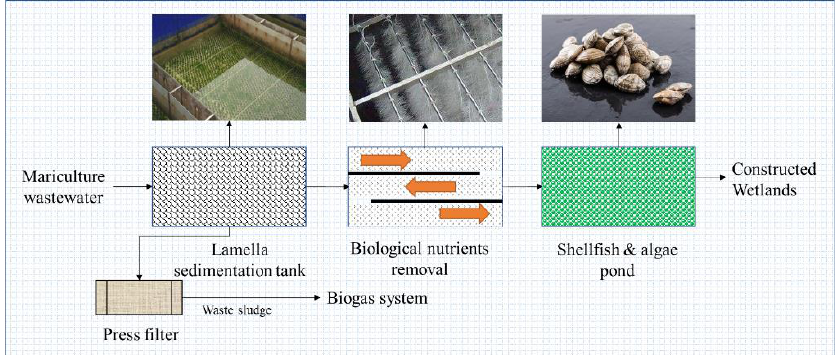
Figure 3. Wastewater treatment technology of large-scale mariculture plants. For small-scale farmers in mariculture zones, local governments can control the amount of water used by fisheries and centralize wastewater treatment (Figure 4). The mariculture wastewater of each farmer is first treated in its own Lamella sedimentation tank. The residual feed and excrement are transported for centralized disposal, and the supernatant is discharged into the public drainage ditch or pipe network. Only the con- centrations of suspended sludge are needed to be controlled at each wastewater